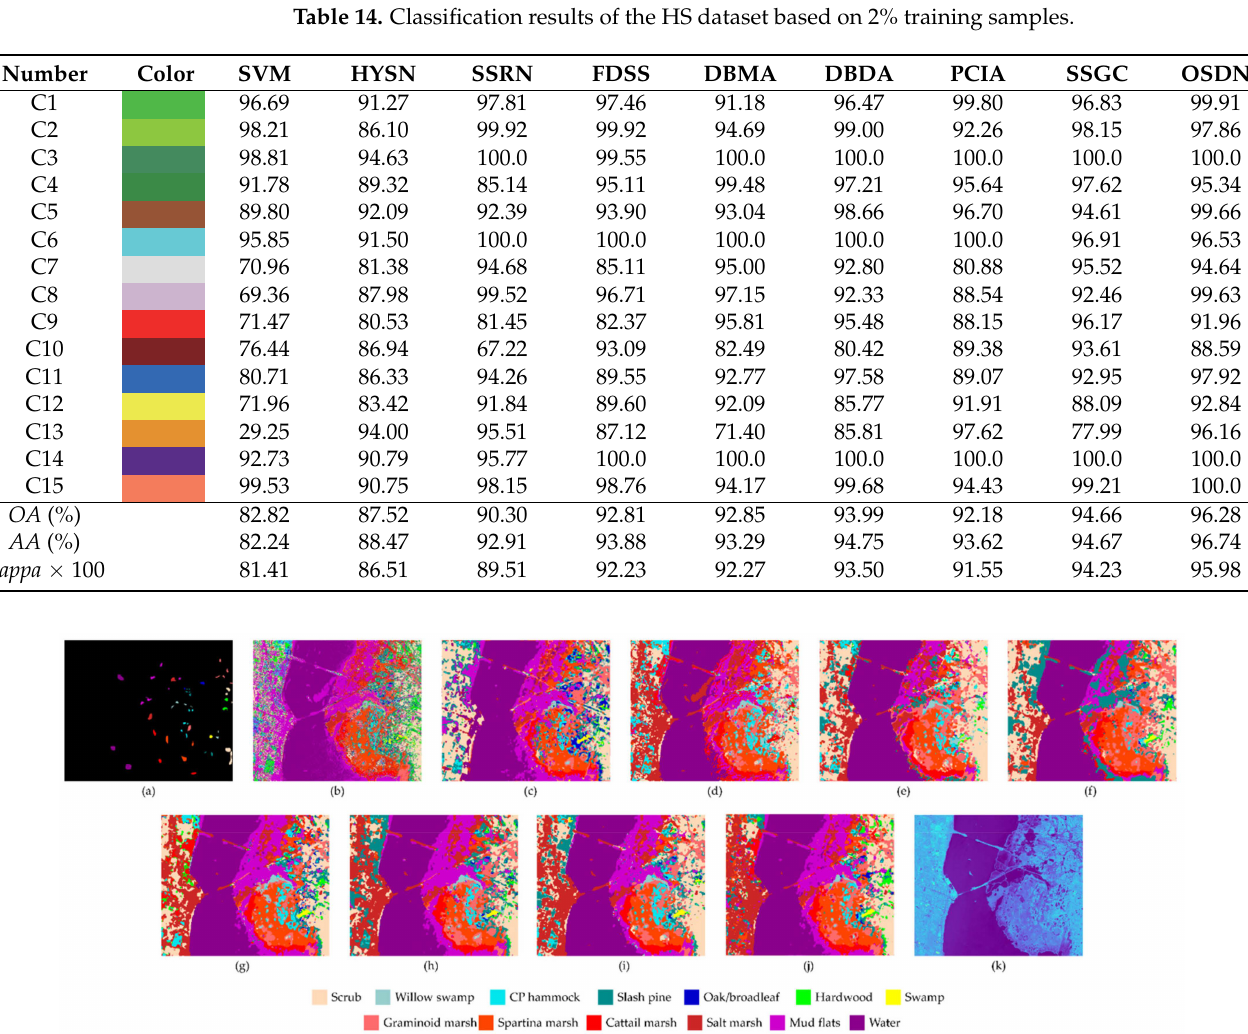
Table 14. Classification results of the HS dataset based on 2% training samples.